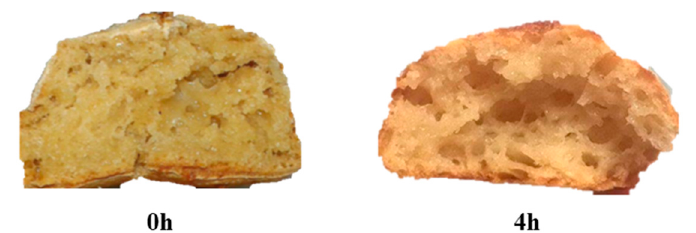
Figure 6. Picture of transversal cut of two of the baked biscuits. 0 h control biscuit, 4 h biscuit made from flour fermented for 4 h.